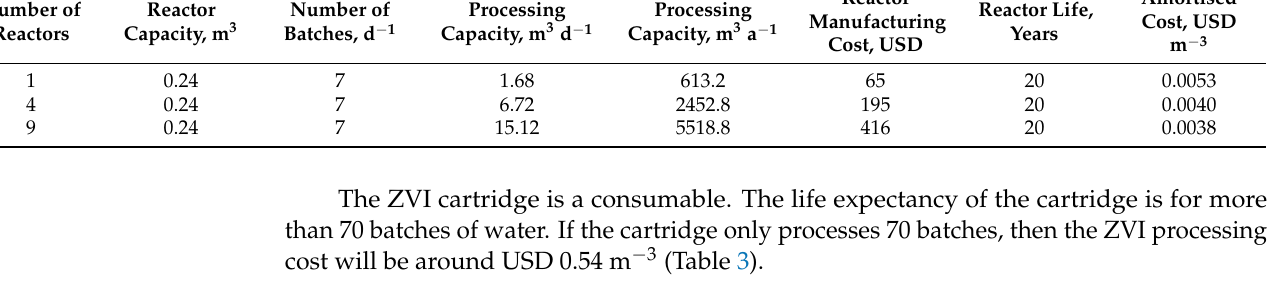
Table 3. ZVI cartridge manufactured cost.